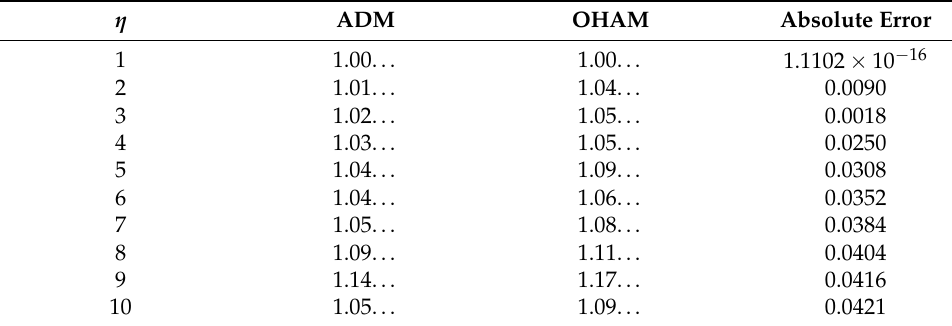
Table 2. OHAM and numerical comparison for θ ( η ) .